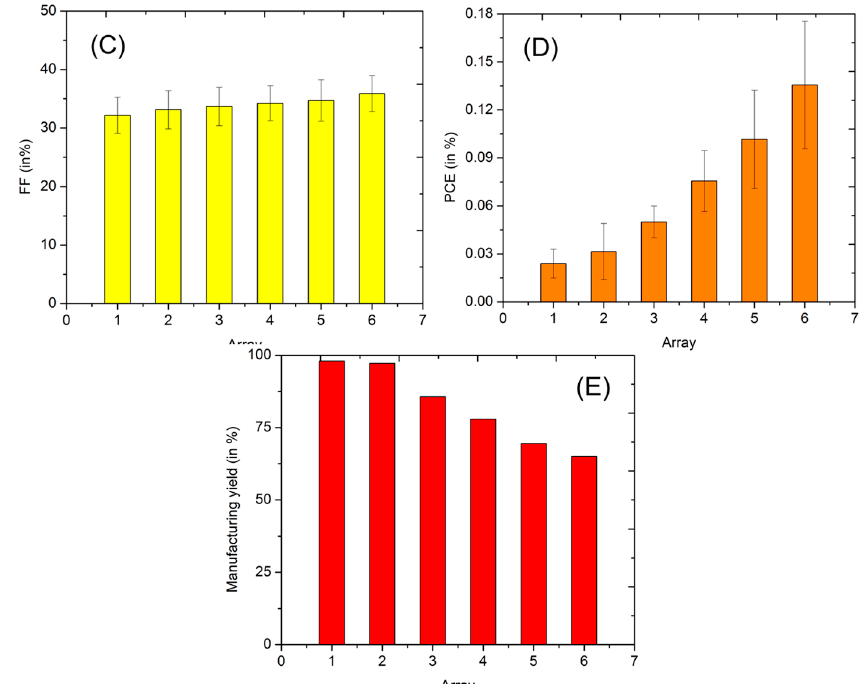
Figure 7. Graphs showing the statistics behind ( A – D ) the electrical properties and ( E ) the manufacturing yield of the all inkjet-printed OPV device arrays having 216 devices, with Arrays 1–6 having active areas of 5 mm 2 , 7.5 mm 2 , 10 mm 2 , 12.5 mm 2 , 17.5 mm 2 , and 20 mm 2 , respectively.